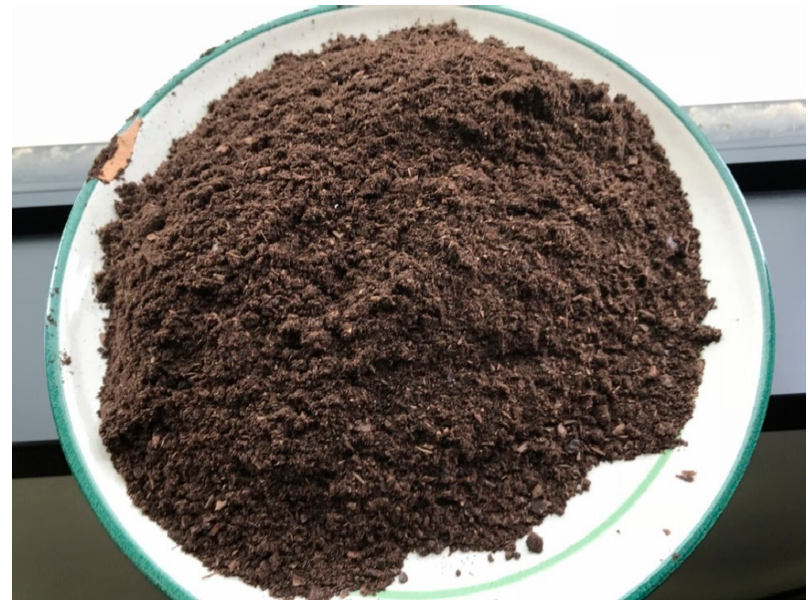
Figure 1. Dried destoned virgin olive pomace (DDVOP).